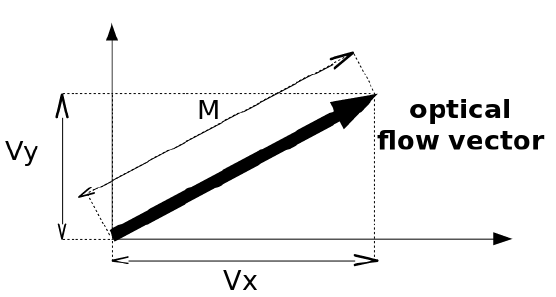
Figure 4. Visualization of M, Vx and Vy for one optical flow